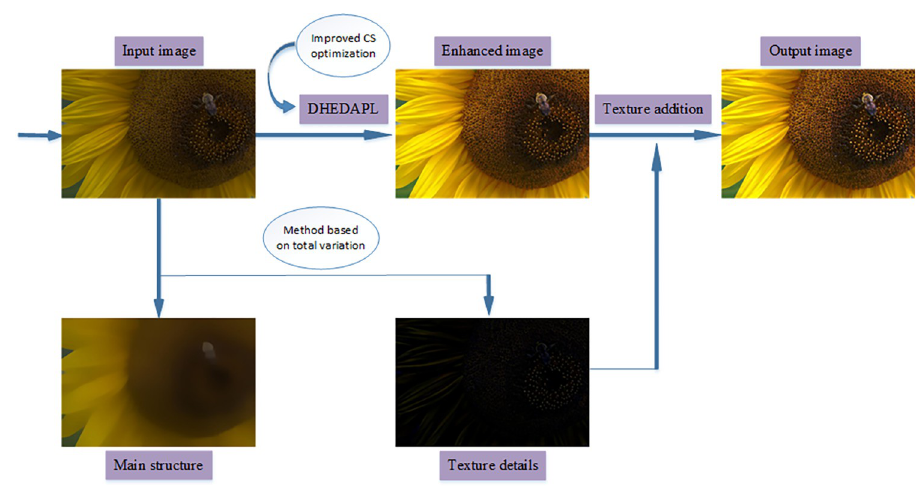
Fig 3. The flow chart of the image processing method proposed in this